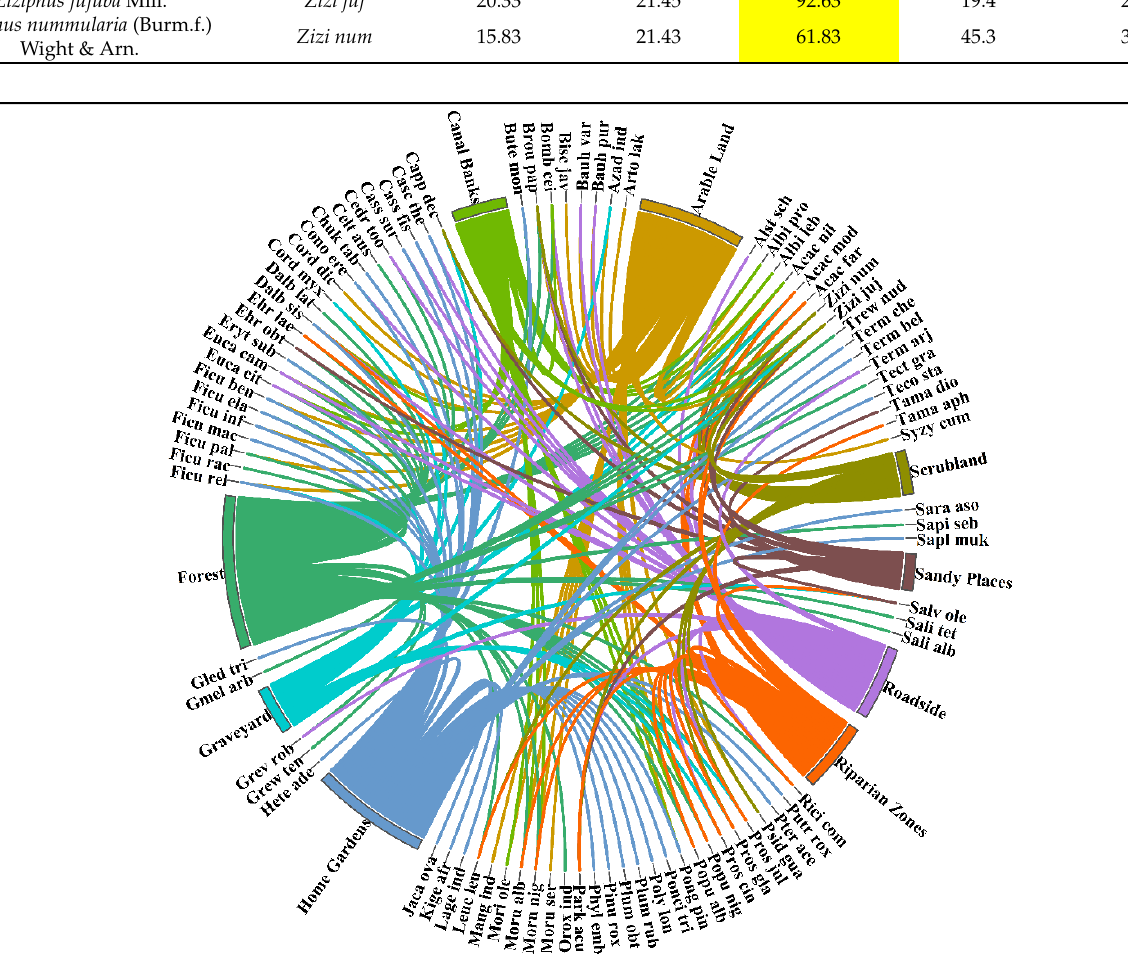
Figure 4. Chord diagram showing the woody species distribution in different habitat types of semi-arid lowland of Punjab, Pakistan.